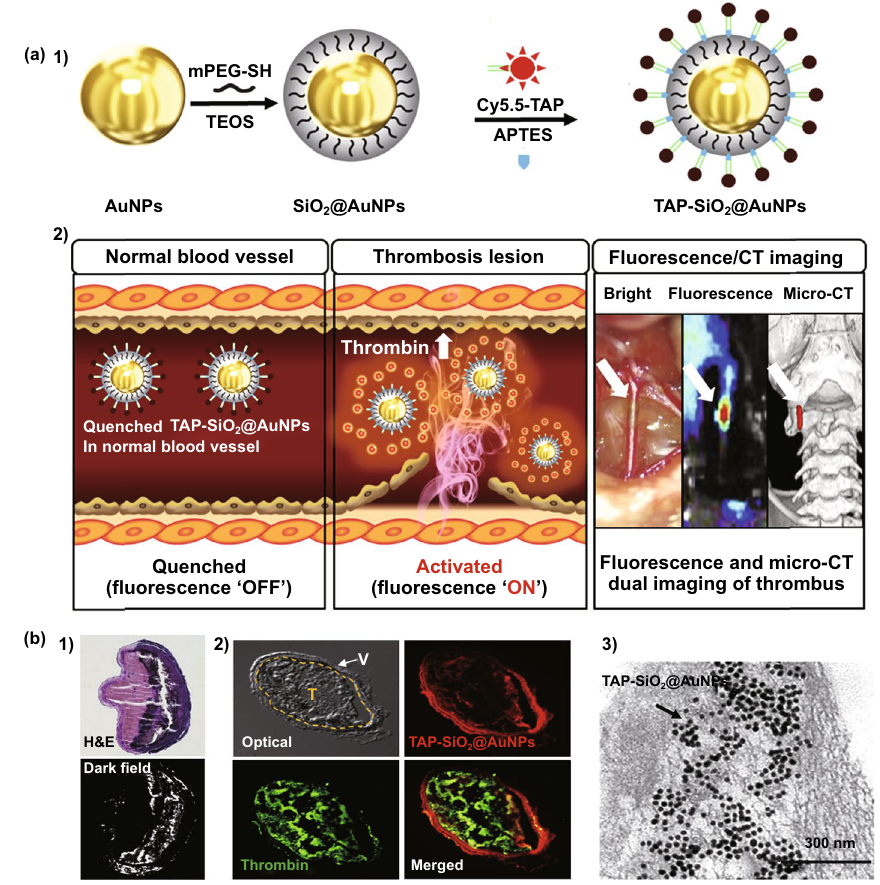
Fig. 4 a Preparation procedure of TAP-SiO 2 @AuNPs ( 1 ); the fluorescence of the multifunctional nanoparticles was quenched, the fluorescence was activated in the thrombosis lesion, the fluorescence/CT dual imaging strategy could be applied for the diagnosis of thrombosis ( 2 ). b The H&E staining/dark field images ( 1 ), immunofluorescence images ( 2 ) and tissue TEM ( 3 ) of dissected-CCA from the TAP-SiO 2 @AuNPs-treated thrombotic model [58]. Copyright 2018 Elsevier